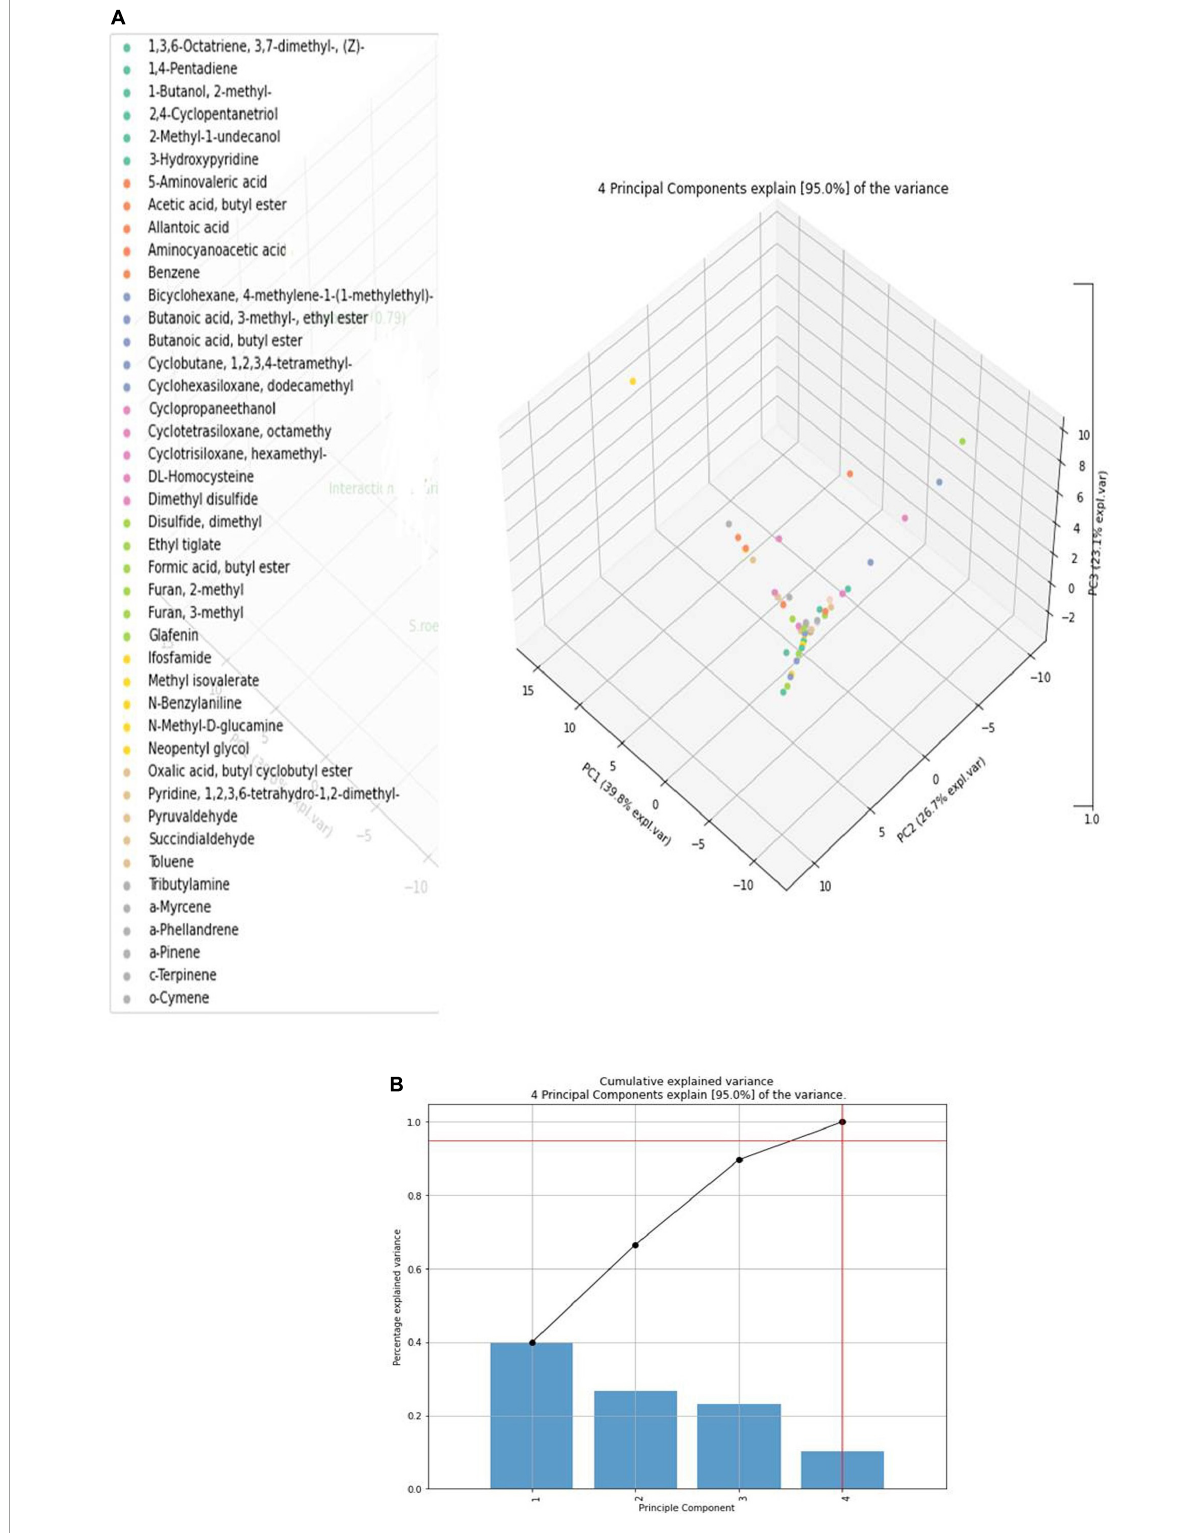
FIGURE4 (A) Classes of volatile compounds obtained from axenic and co-cultivation. (B) Scree plot for volatile compounds obtained in GC-MS-TD in axenic and